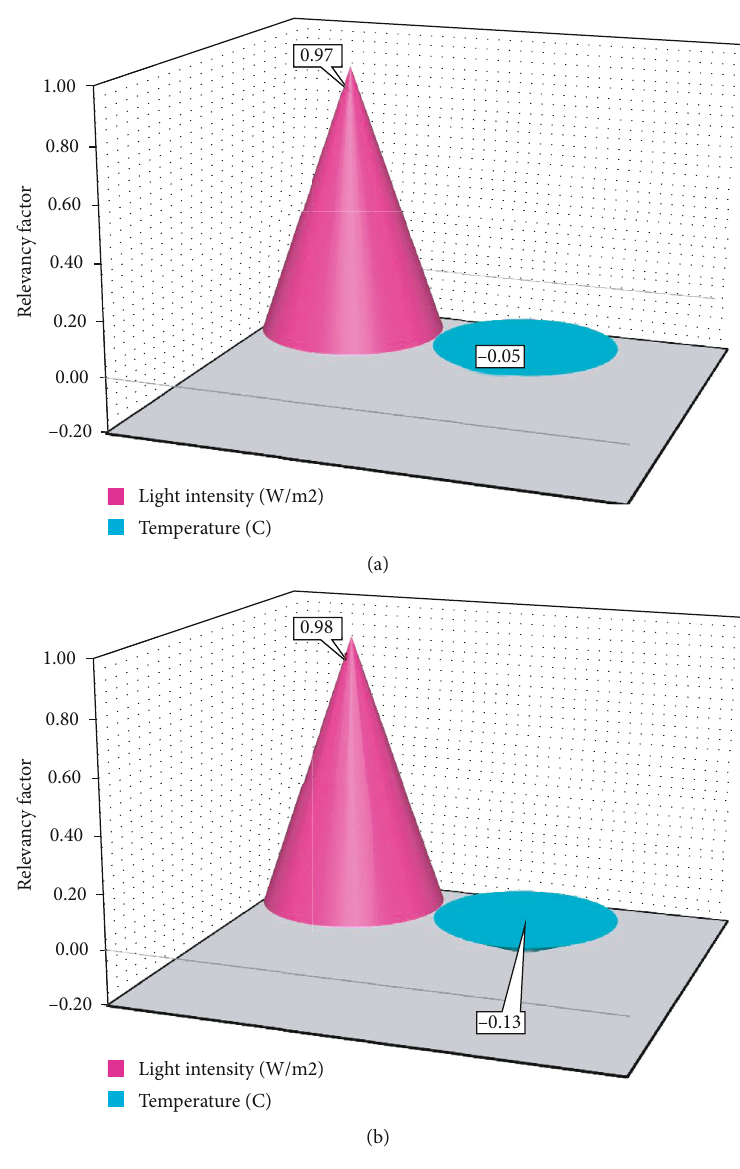
Figure 9: Impacts of input parameters on output power of (a) monocells and (b)